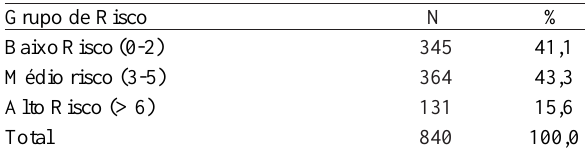
Tabela 3. Distribuição amostral, segundo os Grupos de Risco do